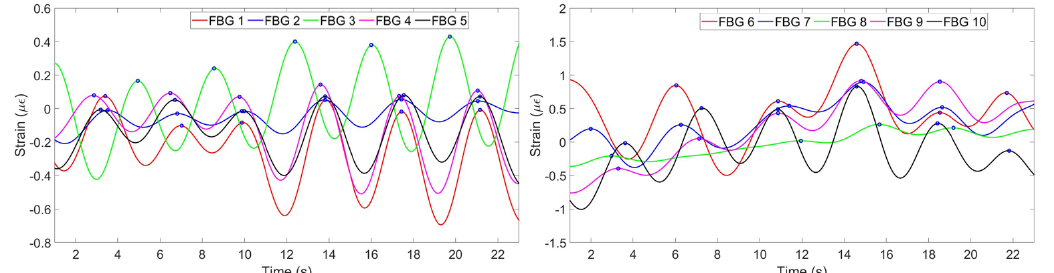
Figure 7. Strain pattern after application of filter detected by 5 FBGs on the chest ( left ) and by 5 FBGs on the abdomen ( right ).